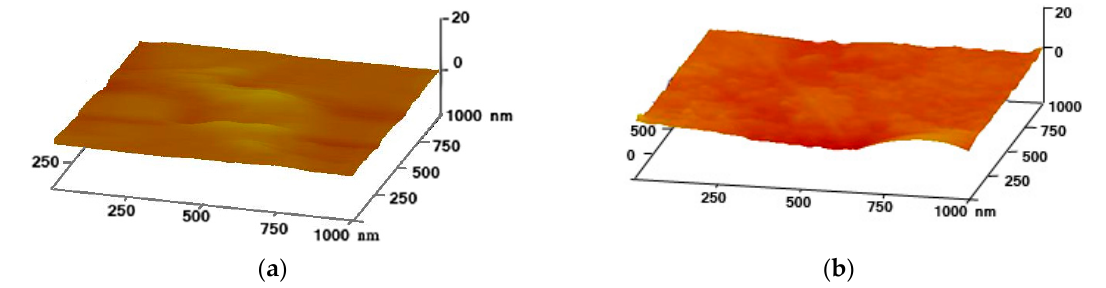
Figure 2. AFM images of membrane surfaces: ( a ) Р 84 and ( b ) Р 84/ND.